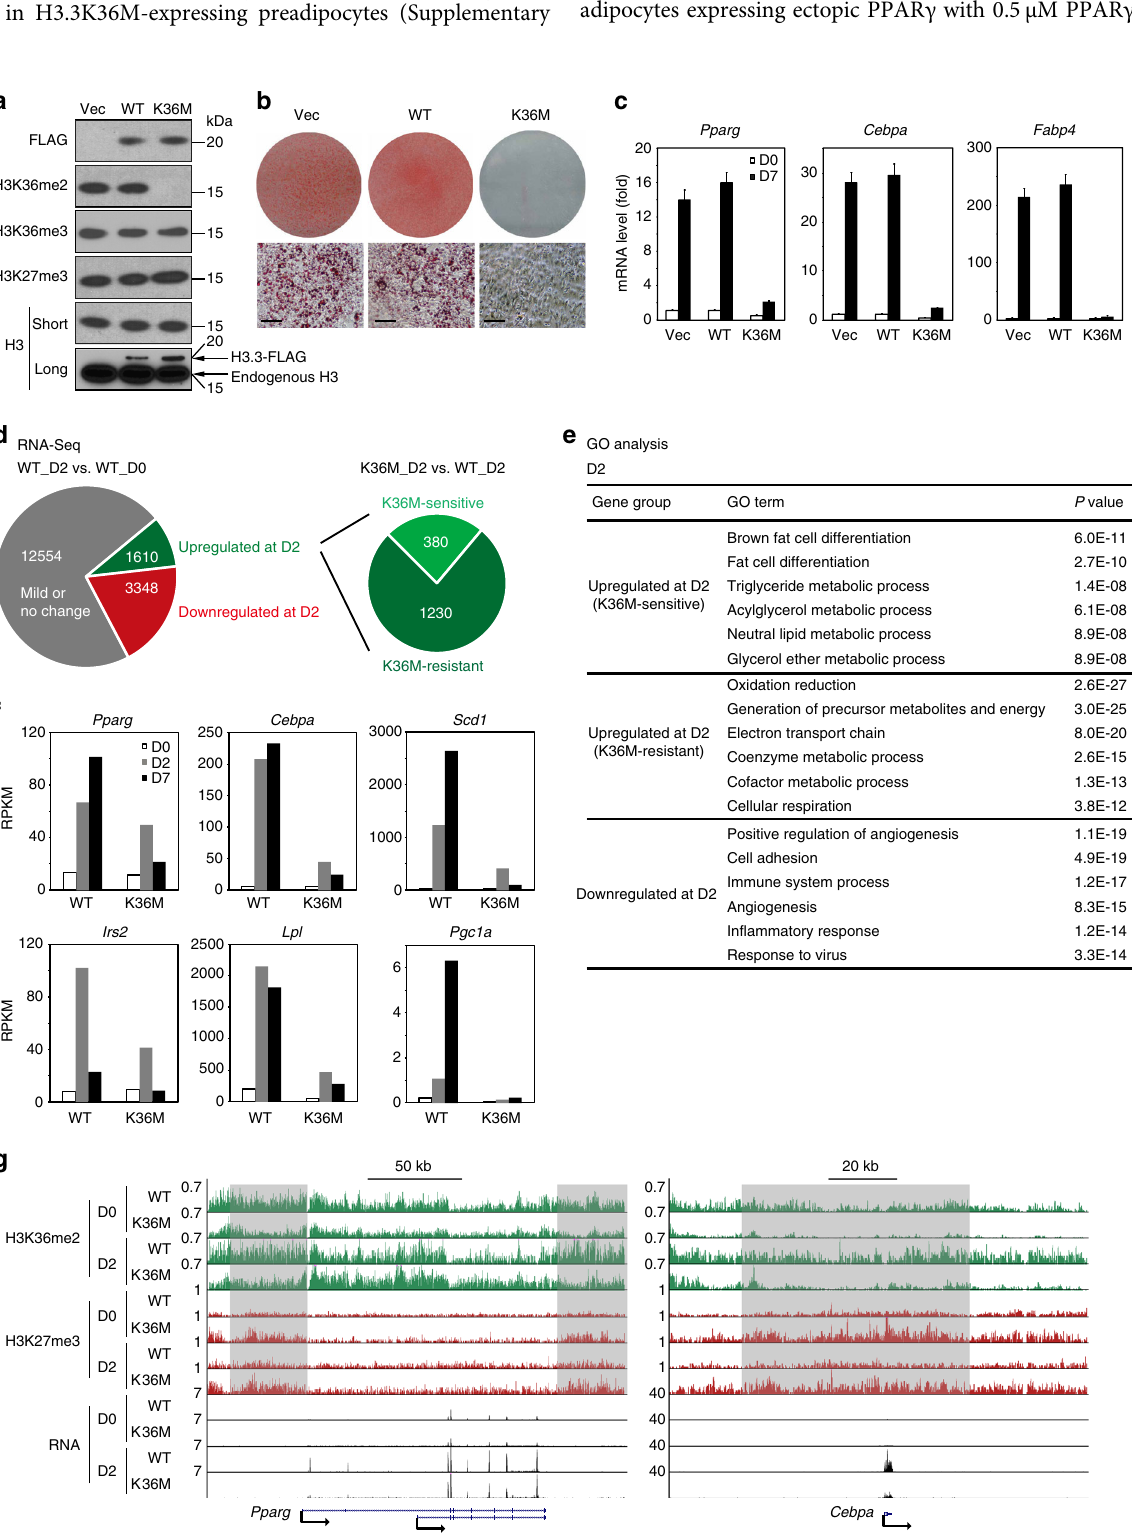
Fig. 4a and Fig. 2a). Ectopic expression of either C/EBP α or PPAR γ failed to fully rescue the adipogenesis defect in H3.3K36M-expressing preadipocytes (Supplementary Fig. 4b, c and Fig. 2b, c). Since H3.3K36M impaired the induction of Cebpa and other PPAR γ target genes during adipogenesis (Fig. 2c), we speculated that H3.3K36M might inhibit PPAR γ target gene activation. To test this possibility, we treated sub-con fl uent pre-